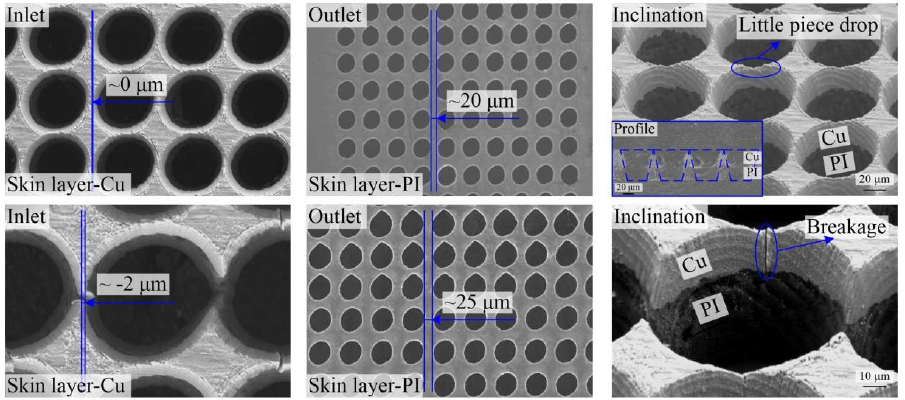
Figure 10. SEM images of through-holes with multiple inlet pitches in single-sided board.